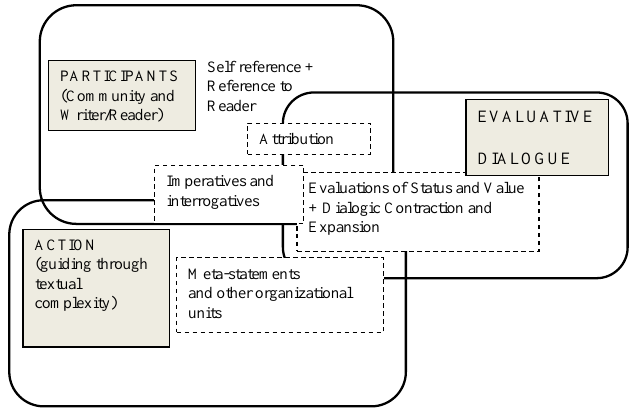
Figure 1. Elements of dialogicity [44] (p. 146).